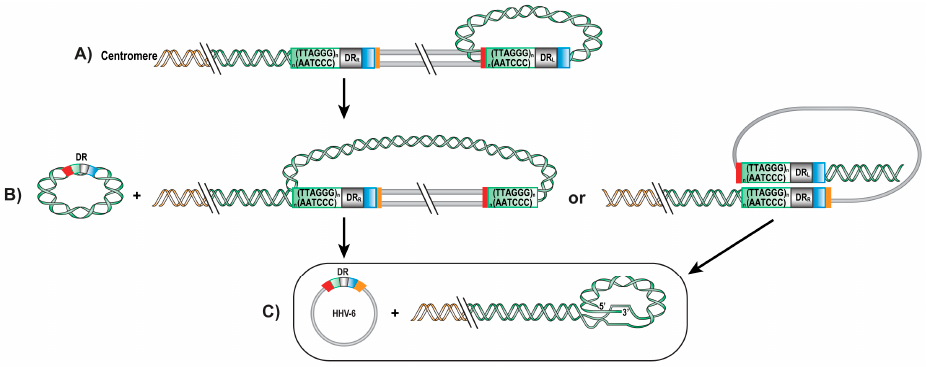
Figure 2. Possible mechanisms of HHV-6A/B genome excision from telomeres. Schematic representation of hypothetic processes of HHV-6A/B genome excision from telomeres. ( A ) Telomeric repeats form a t-loop in the TMR of HHV-6A/B DR L , followed by recombination and excision, resulting into a first t-loop excision: a telomeric circle and a chromosomally integrated HHV-6A/B lacking a